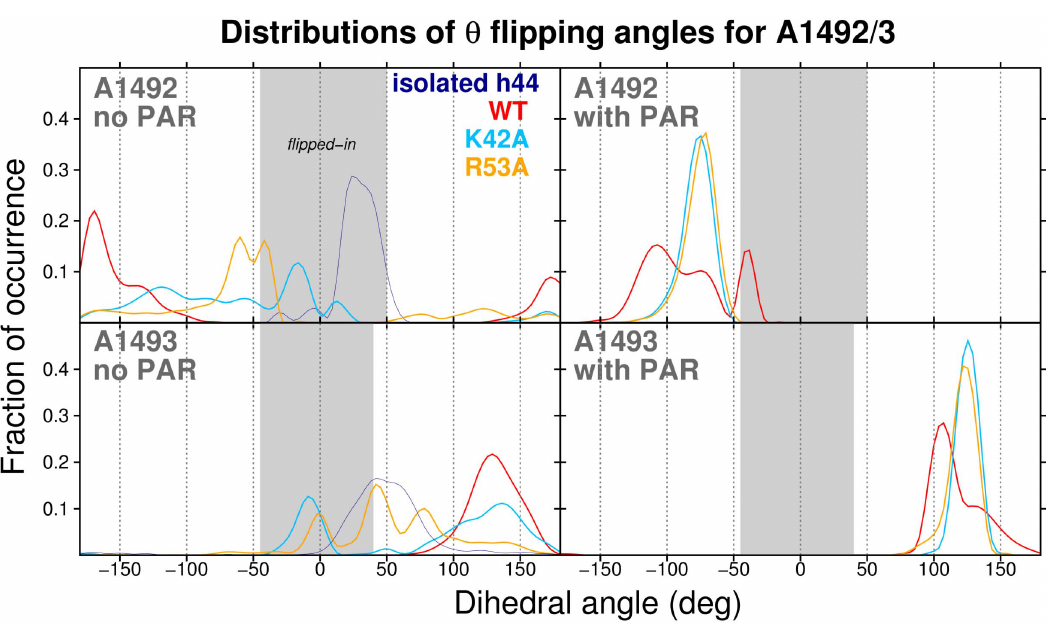
Figure 3. Flipping of A1492 and A1493. Distributions of the pseudo-dihedral angle ( h ) can quantify nucleotide flipping. The shaded region corresponds to flipped-in configurations. The h angle and the ‘flipped-in’ h ranges are defined in Fig S1 in File S1) and in the ‘Methods’ section. The data are cumulative from three independent MD trajectories per simulation system variant.